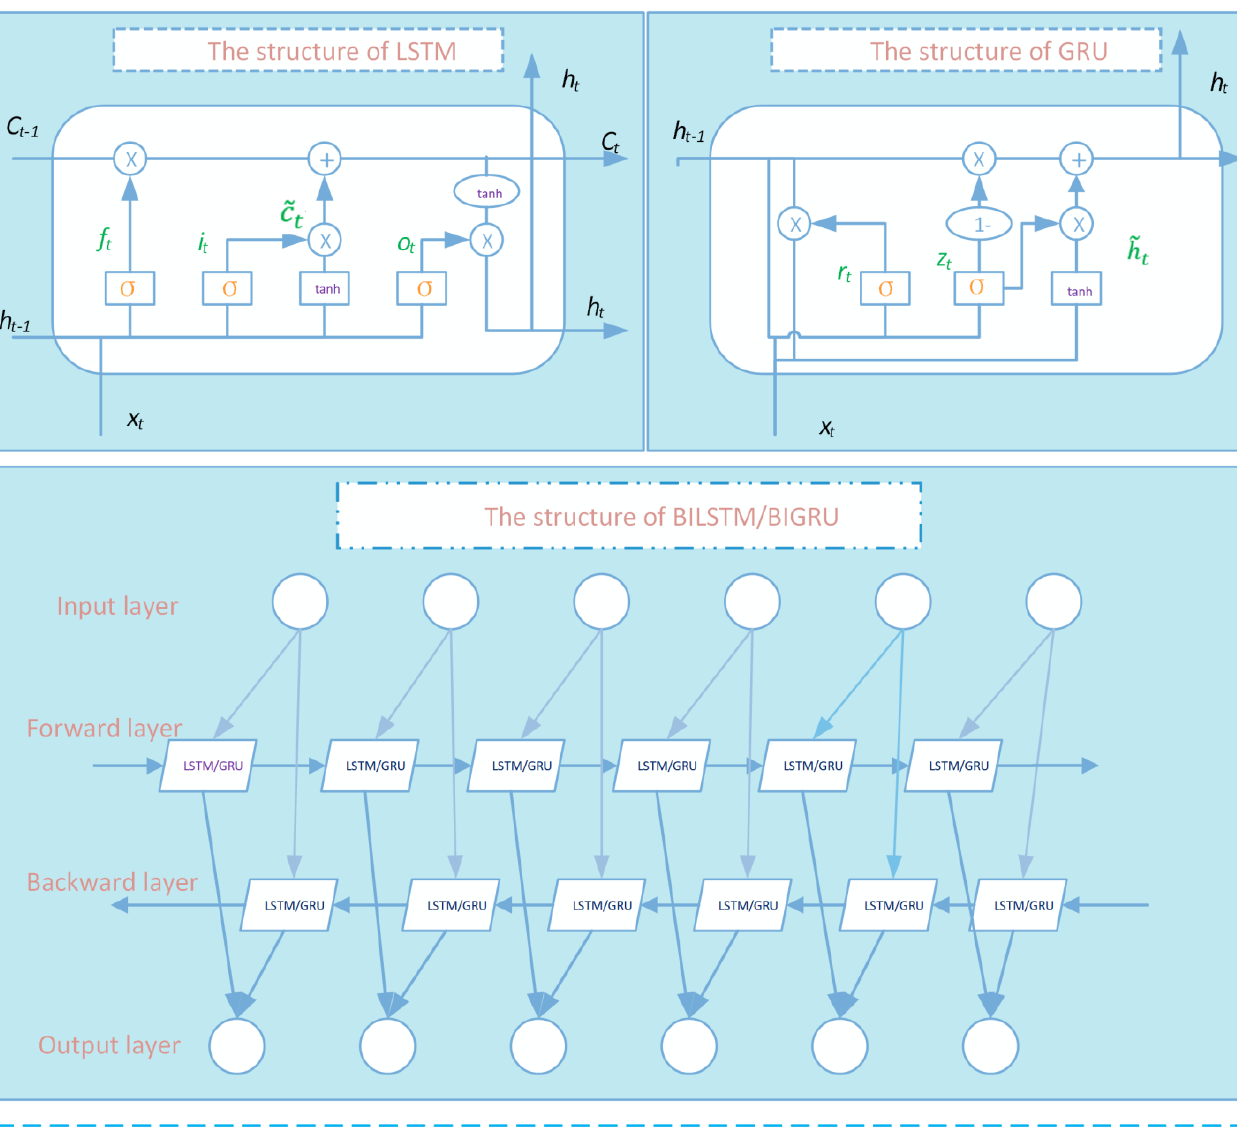
Figure 1. Structure of BILSTM and BIGRU.